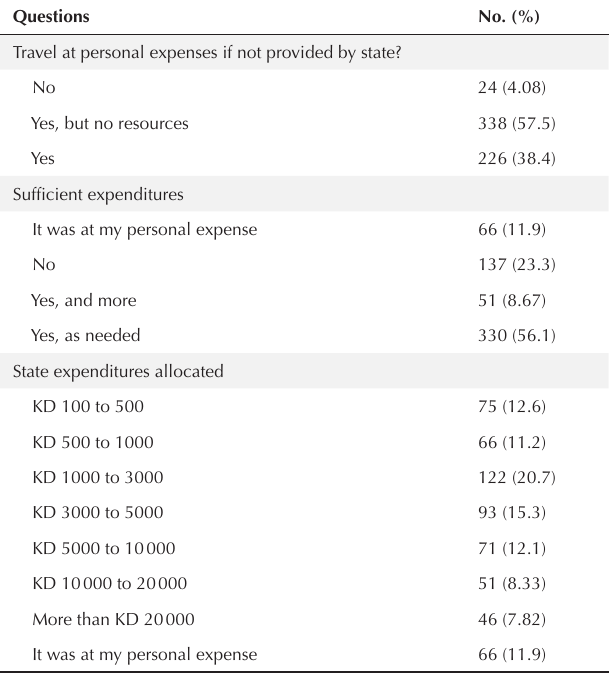
Table 5. Expenditures for Medical Treatment Abroad Questions